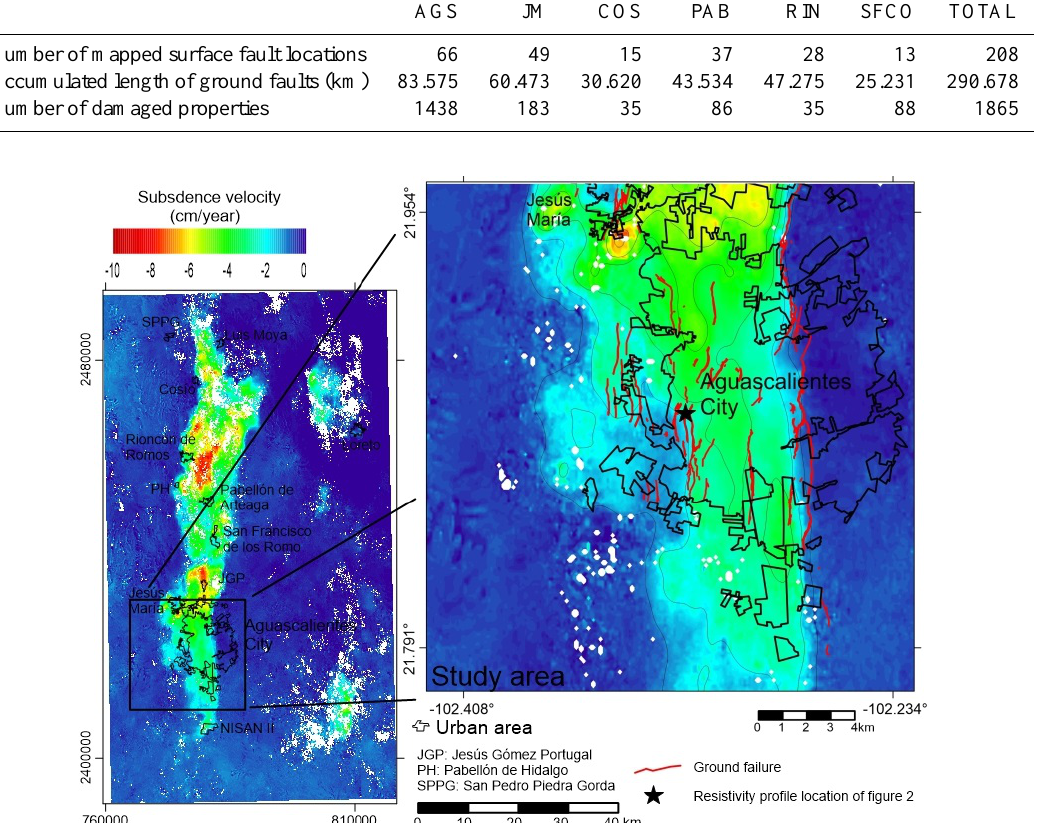
Figure 3. Subsidence velocity map of Aguascalientes Valley as determine from InSAR time series analysis of 2007–2011 ALOS